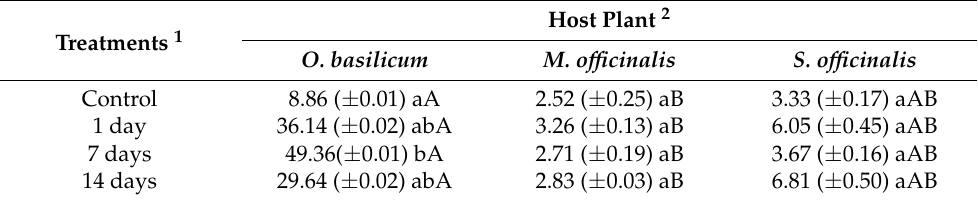
Table 3. Hydrogen peroxide concentration (nmol g − 1 FW) within leaves of Ocimum basilicum , Melissa officinalis and Salvia officinalis after Tetranychus urticae infestation.